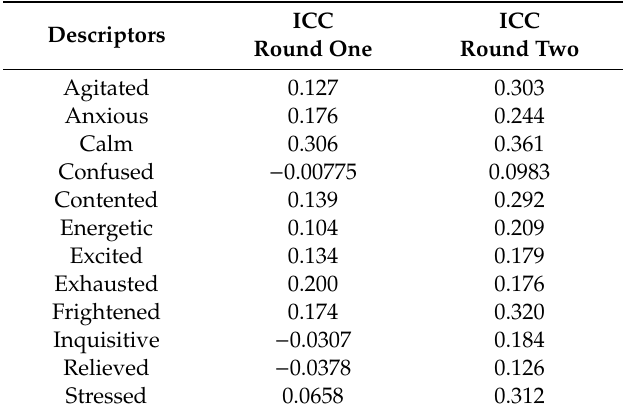
Table 4. Intra-Class Correlation Coe ffi cients for Round One (seven practitioners on 40 images of calves) and Round Two scoring (16 students on 80 images of calves) of fixed term descriptors of calves in a calf roping